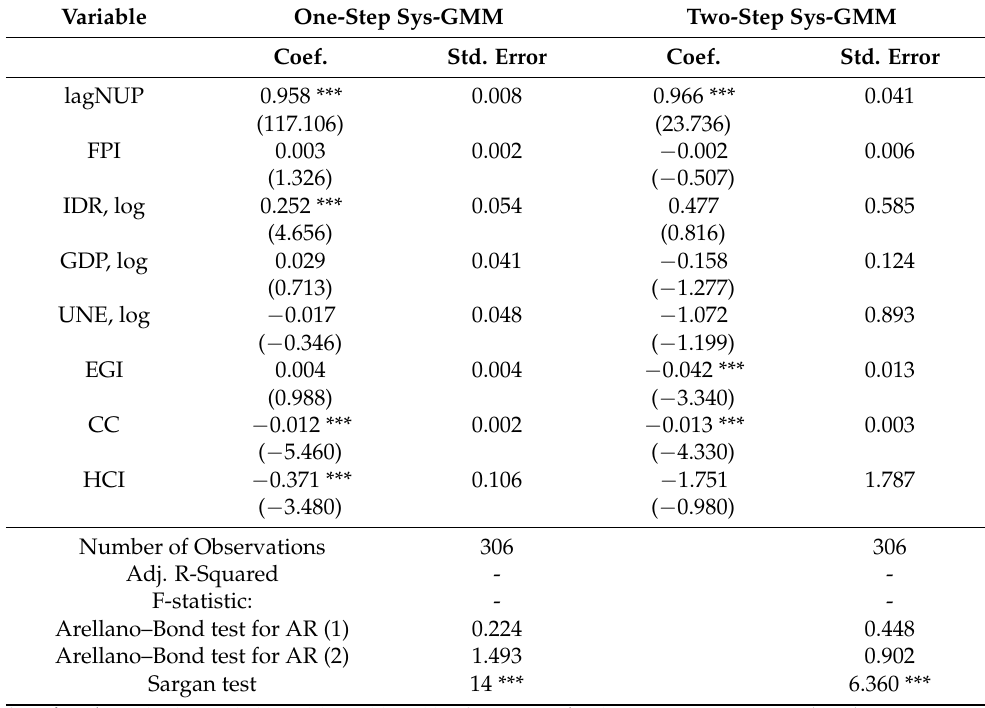
Table 4. Regression results of one and two-step sys-GMM estimations for Asian countries.